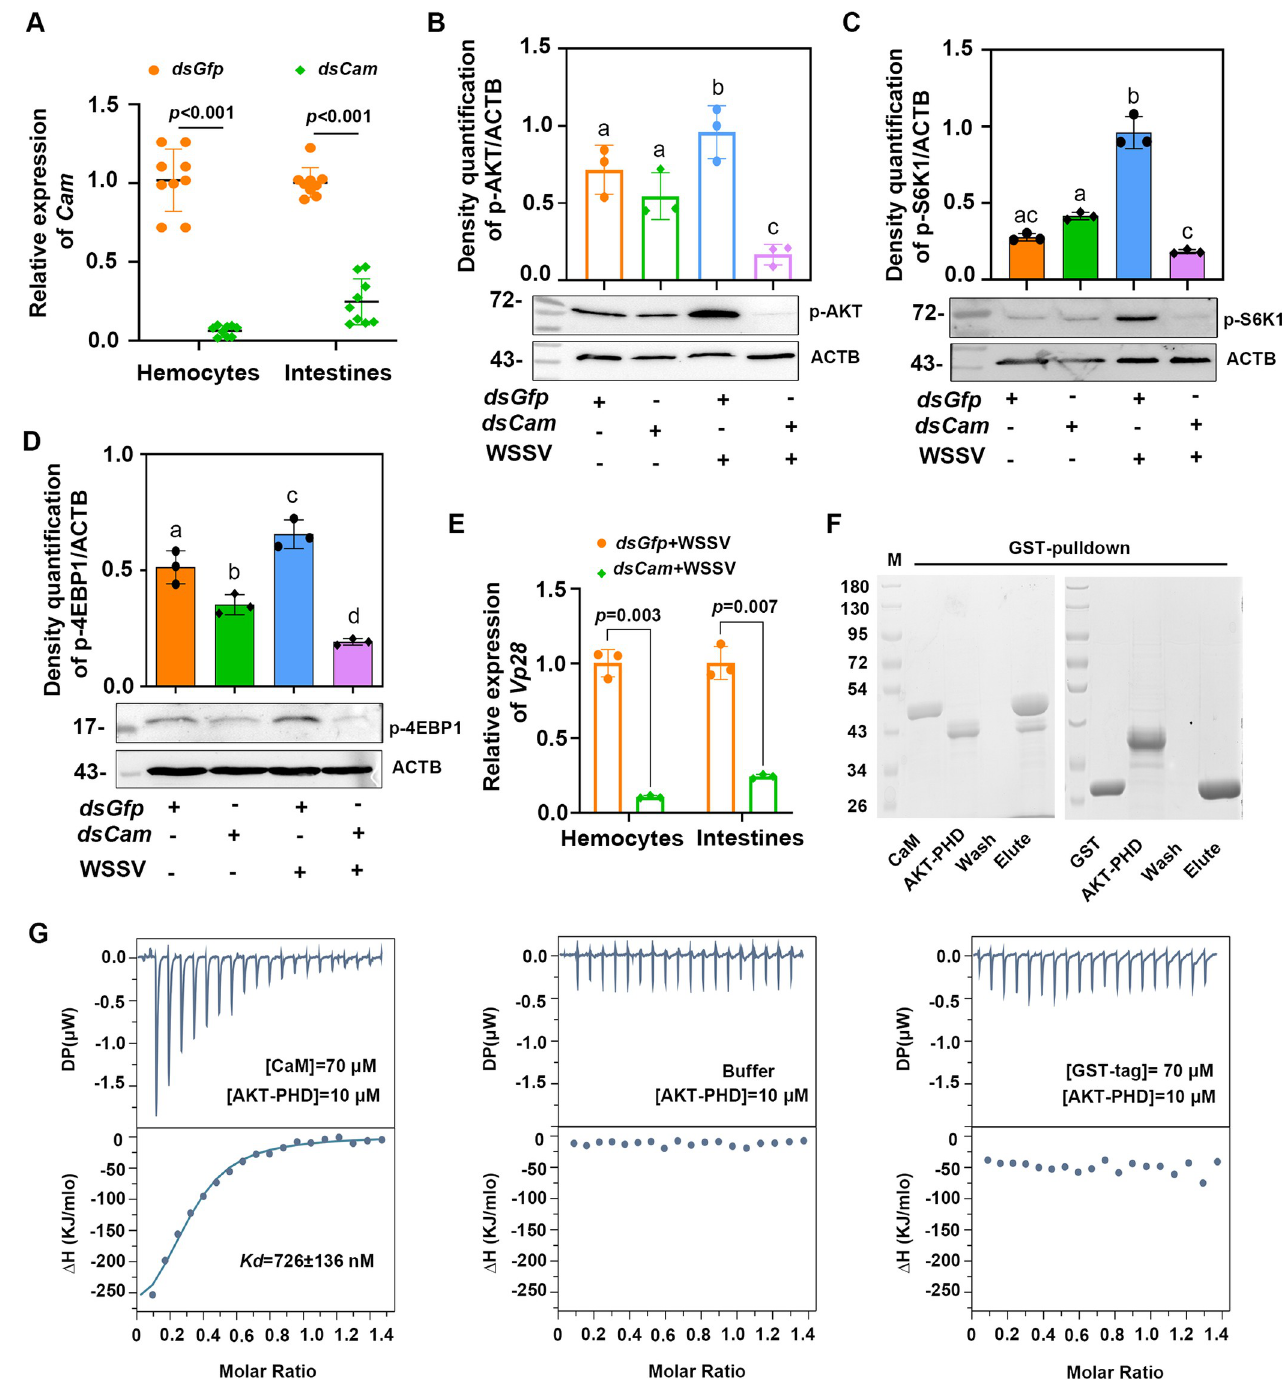
Fig 7. WSSV infection activates mTORC1 signaling via the pIgR-CaM-AKT cascade in shrimp. ( A ) Efficiency of Cam -RNAi in the hemocytes and intestines of shrimp analyzed by qPCR at 36 h post dsRNA injection. ( B ) The level of AKT phosphorylation in the hemocytes of Cam -RNAi shrimp with or without WSSV infection analyzed by Western blot at 36 hpi. ( C ) Phosphorylation of S6K1 in the hemocytes of Cam -RNAi shrimp with or without WSSV infection analyzed by Western blot at 36 hpi. In panel B and C, the subpanels of pAKT/p-S6K1 and ACTB were from different gels with same amount of loading samples. ( D ) Phosphorylation of 4EBP1 in the intestines of Cam -RNAi shrimp with or without WSSV infection analyzed by Western blot at 36 hpi. ( E ) The level of Vp28 mRNA expression in the hemocytes and intestines of Cam -RNAi shrimp challenged by WSSV analyzed by qPCR at 36 hpi. ( F ) Interactions between CaM and AKT-PHD were detected using GST pull-down assays using GST tag as a control. ( G ) Measurements of the binding affinity between CaM and AKT-PHD by ITC. The upper panels show the differential heat released following baseline subtraction of CaM and AKT (left), control buffer (middle),